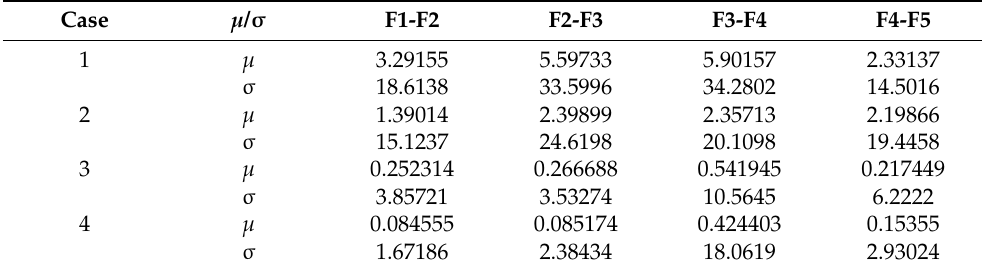
Table 1. Mean and standard deviation of point cloud frame